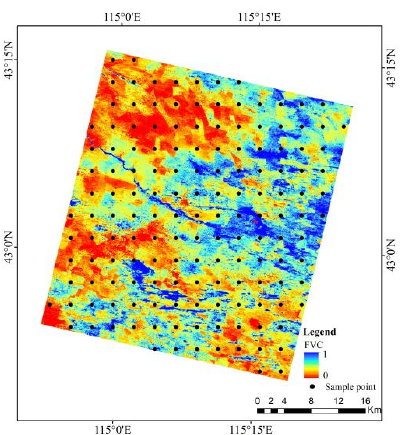
Figure 10. Distribution of sample points in the grid of a Google Earth image.